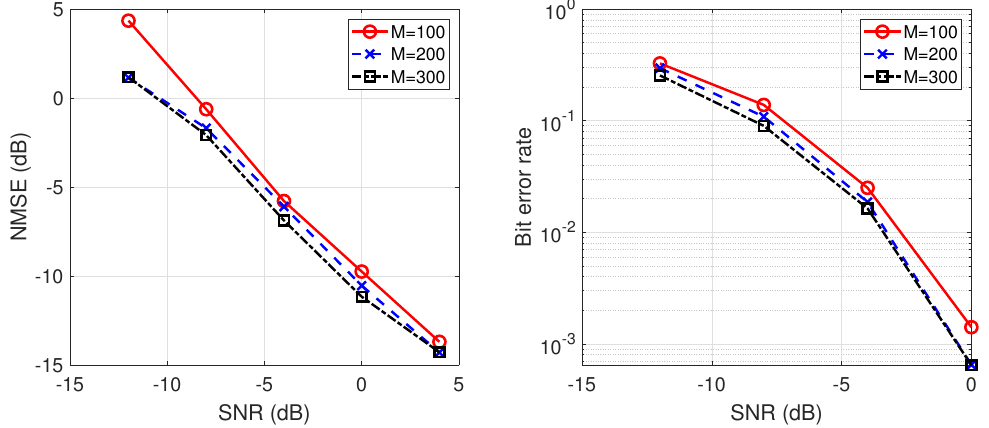
Figure 8. NMSE of estimated spreading waveform and BER of information sequence ( I = 2, L = 63, G = 30, R = 3).